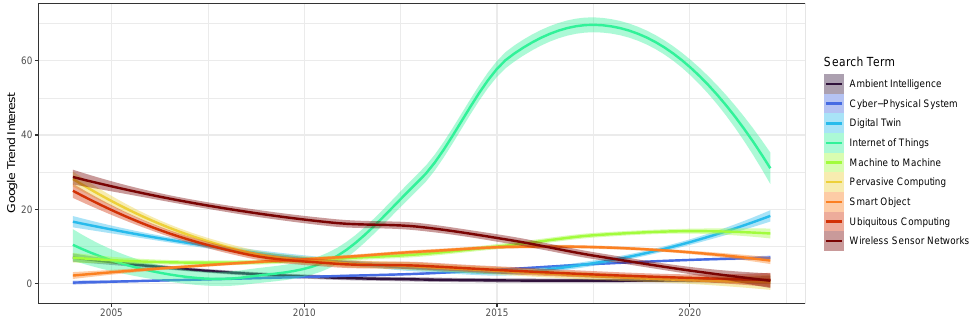
Figure 12. Google search trends by search term in web searches . Interests are averaged with LOESS across months from 2003 to early 2022. In general, the Internet of Things has been falling since 2017, and Digital Twin has been steadily rising. This year, Digital Twin has become the most searched term among the cognates other than Internet of Things. Terms for underlying technologies and previous system names are stagnating or declining in use. Data collected from https://trends.google.com on 8 February